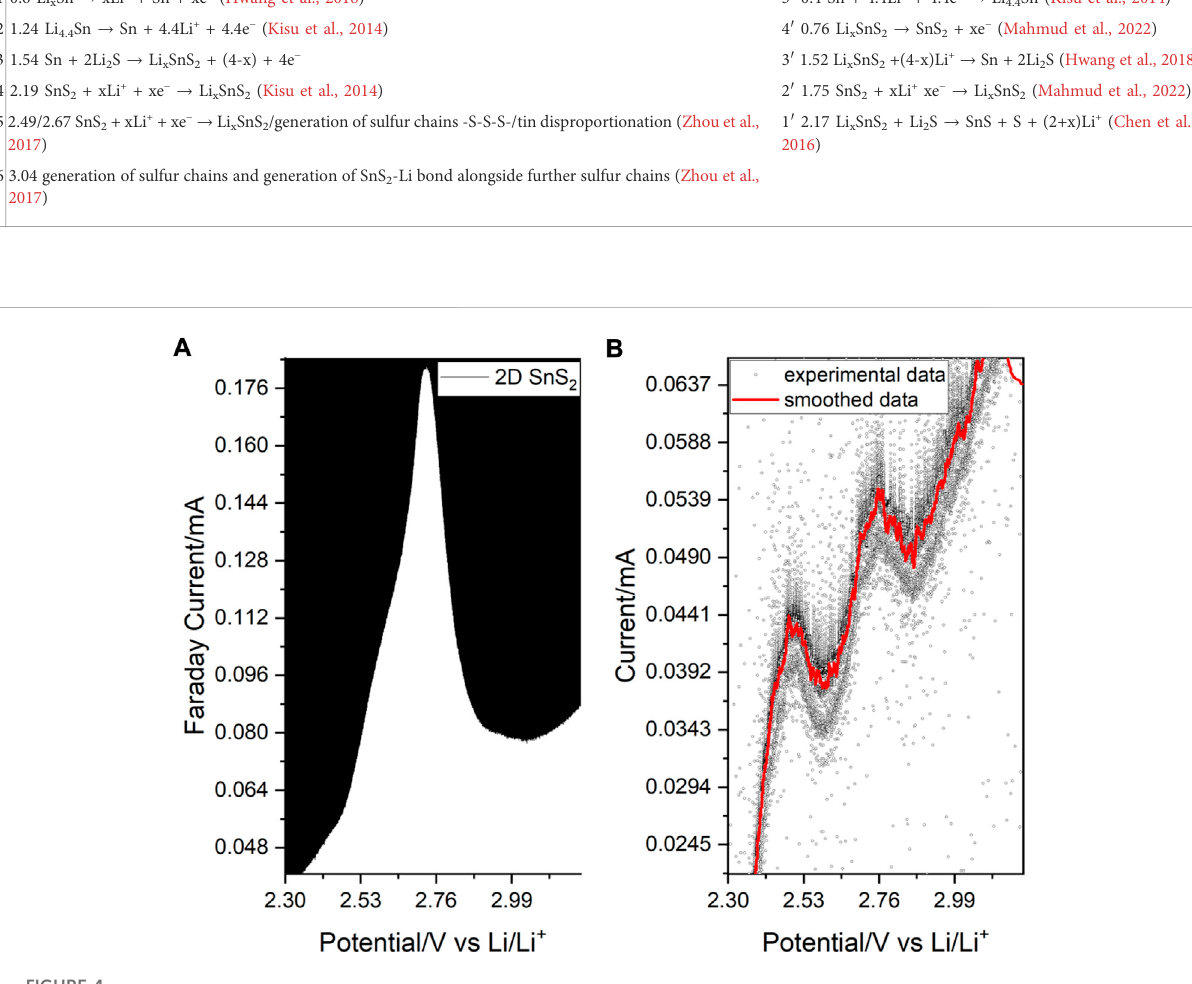
TABLE 1 Reactions taking place during the spectroelectrochemical scan of 2D SnS 2 with the assigned potentials during Li + (de)intercalation/alloying. The numbers refer to Figure 3. Anodic scan reactions and potentials in V